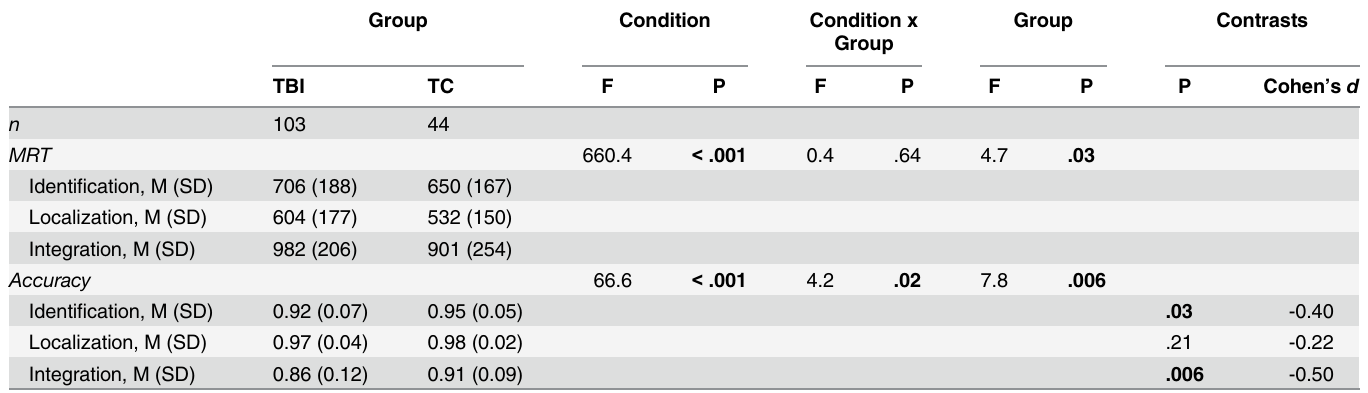
Table 2. MRT and accuracy of Visual Integration Test performance in the TBI and TC groups. Group